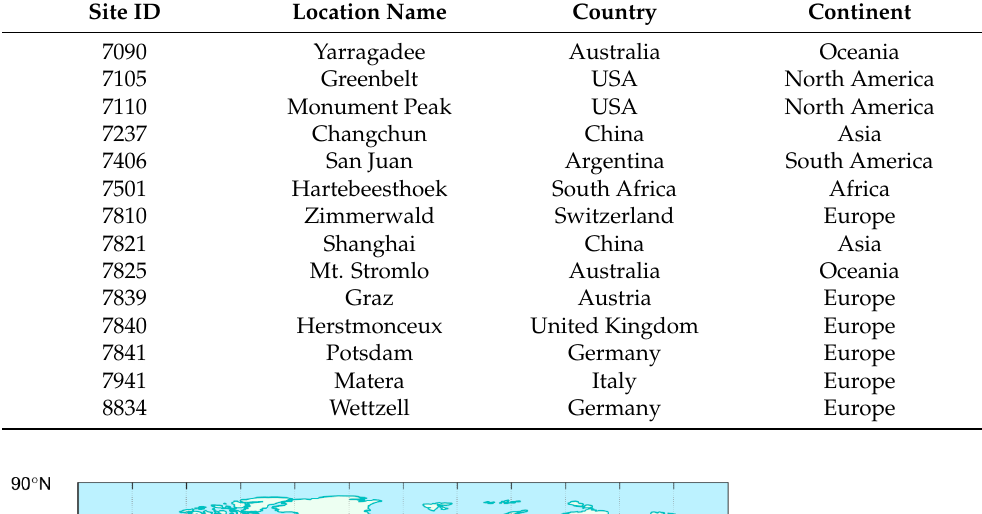
Table 3. Basic information list of the selected SLR sites.